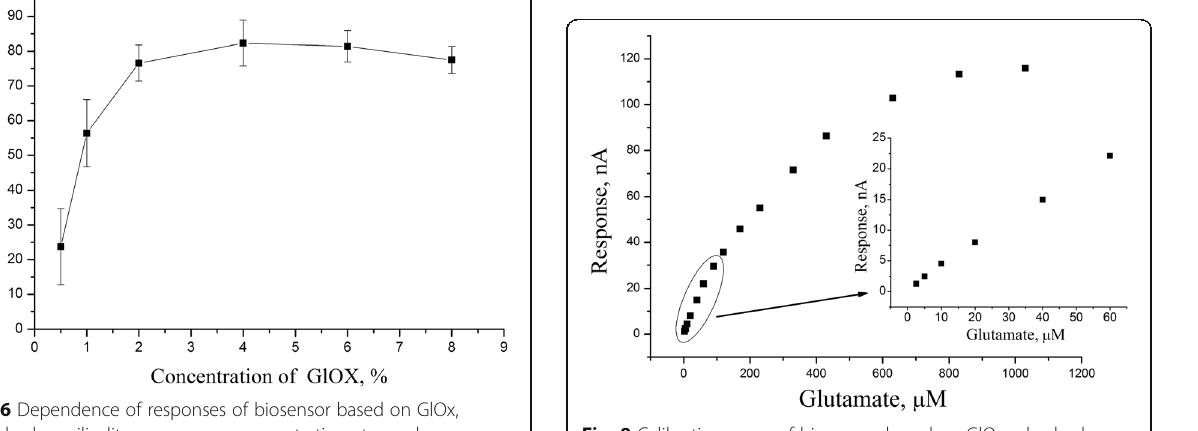
Fig. 8 Calibration curve of biosensor, based on GlOx adsorbed on silicalite, for glutamate determination. Measurements in 20 mM HEPES buffer, pH 7.4, at a constant potential of +0.6 V vs Ag/AgCl reference